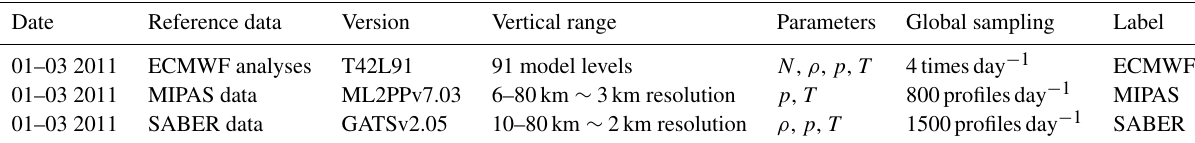
Table 2. Reference data sets for Table 1 on monthly 5 ◦ zonal climatologies.